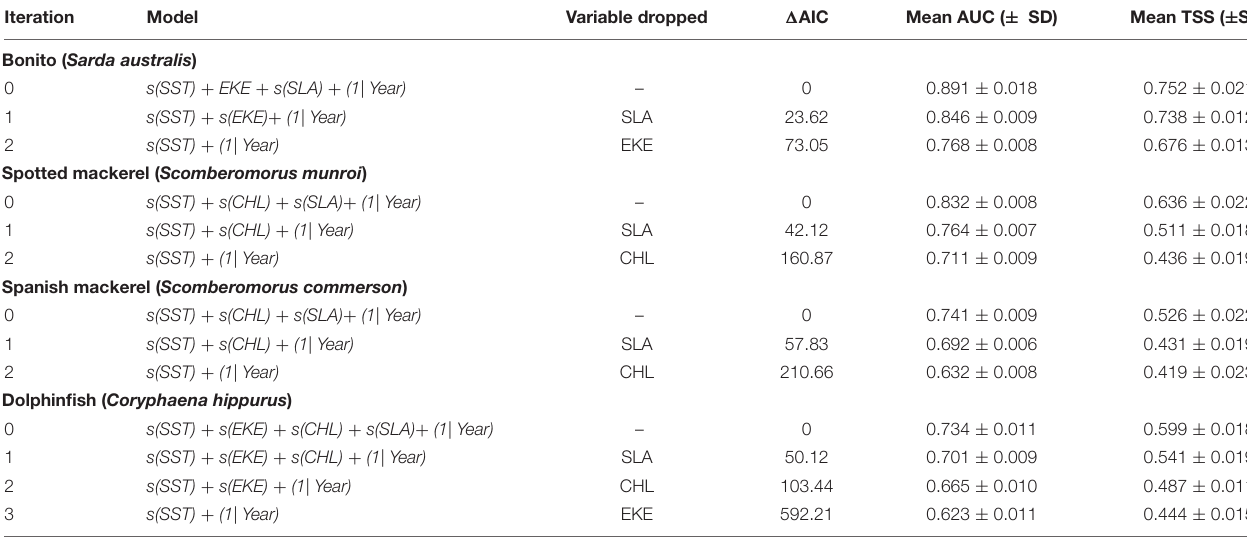
FIGURE 1 | Map of eastern Australia displaying the spatial extent of the study region and the distribution of random samples of 300 species occurrence records (red circles) used in model fitting and 50 independent occurrences (blue circles) used in model testing for bonito ( Sarda australis ), spotted mackerel ( Scomberomorus munroi ), Spanish mackerel ( Scomberomorus commerson ), and dolphinfish ( Coryphaena hippurus ). TABLE 1 | Summary of full models for each species and nested alternatives assessed using an AIC informed model selection procedure on covariate combinations of decreasing